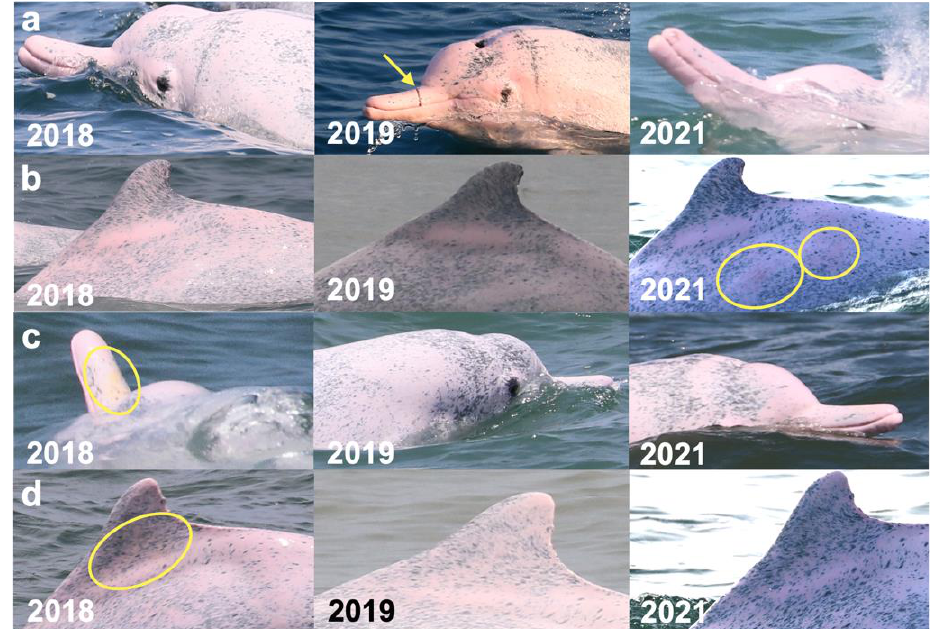
Figure 7. Images of 4 of the 17 resighted individuals in 2018, 2019, and 2021. ( a ) A speckled individual was observed with a new linear wound on its upper jaw only in 2019. ( b ) A speckled individual was found with a new red patch on its left side only in 2021. ( c ) A spotted adult was observed with a yellow patch on its upper jaw only in 2018. ( d ) A speckled-stage individual was found with a yellow patch on the left side of its dorsal fin only in 2018. Arrows and circles: injury or lesion.